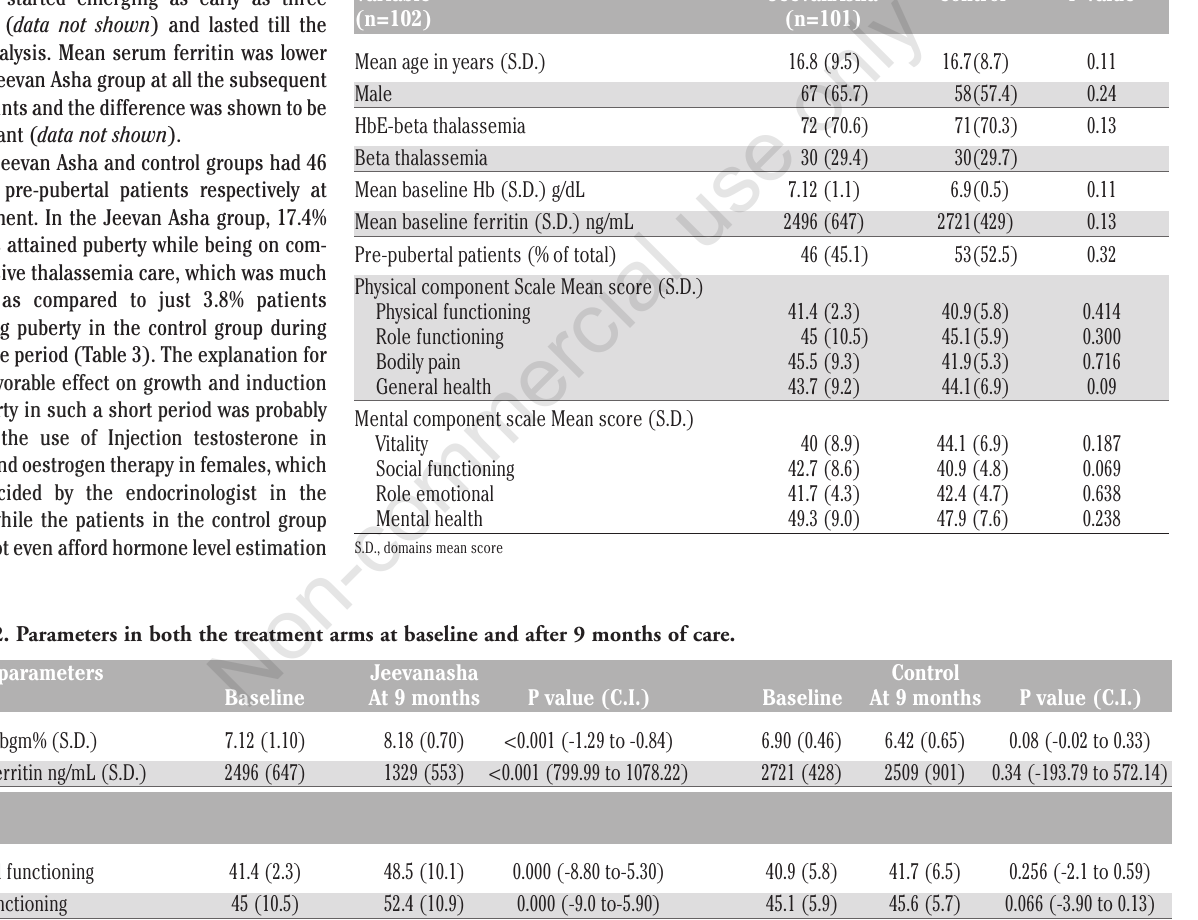
Table 1. The baseline characteristics of patients in both the treatment arms. Variable